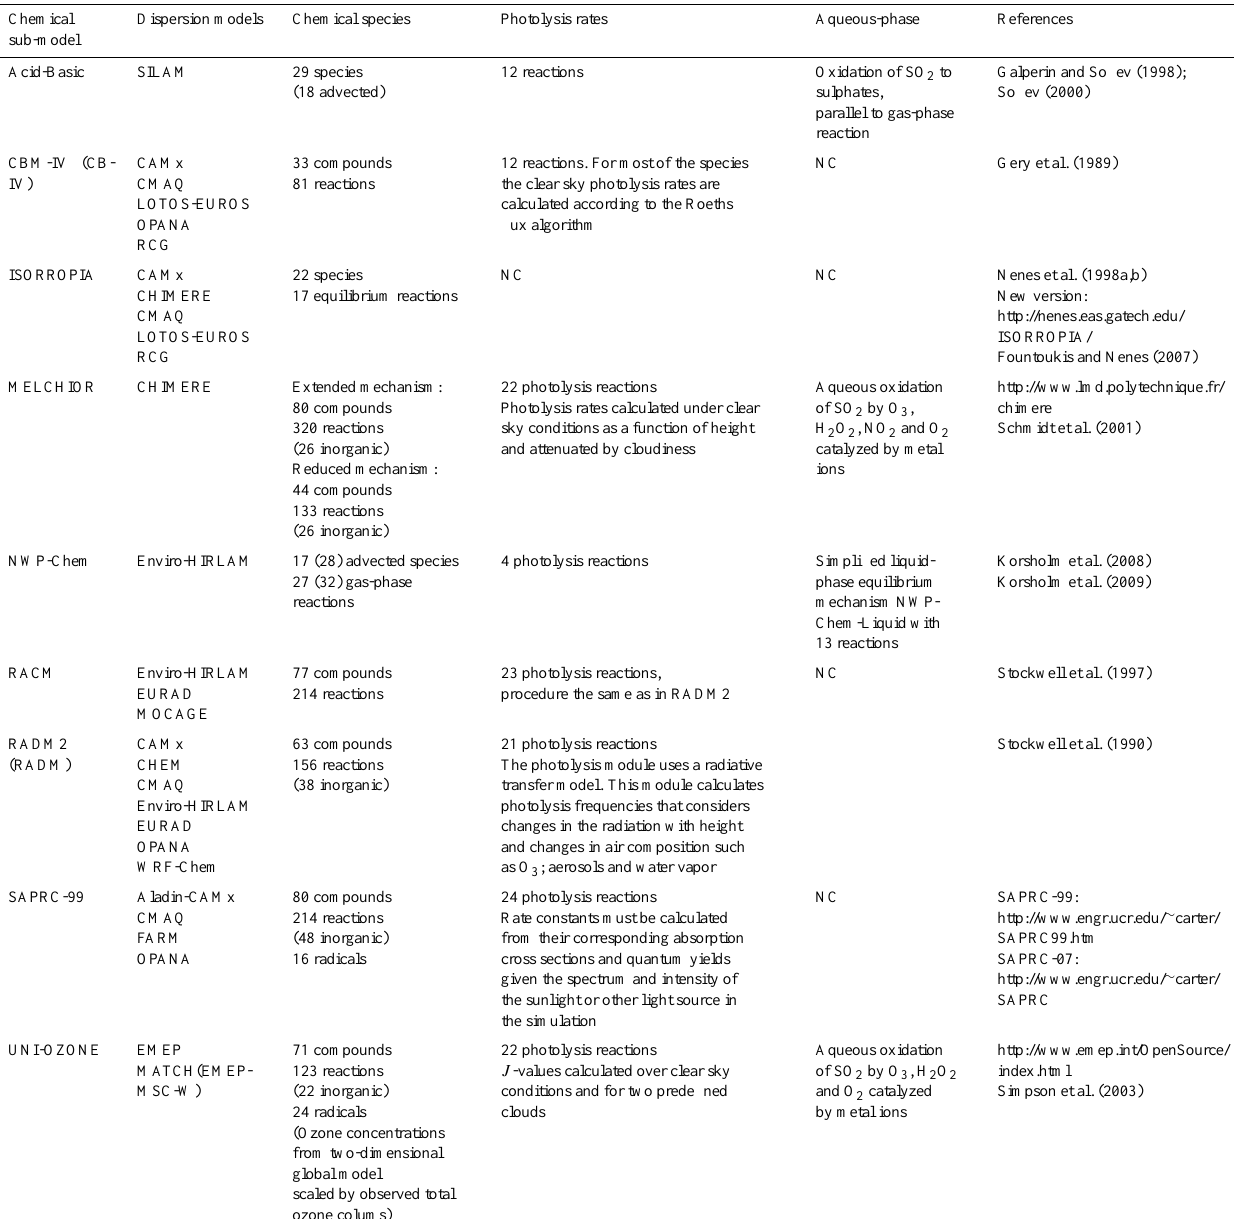
Chemical Dispersion models Chemical species Photolysis rates sub-model